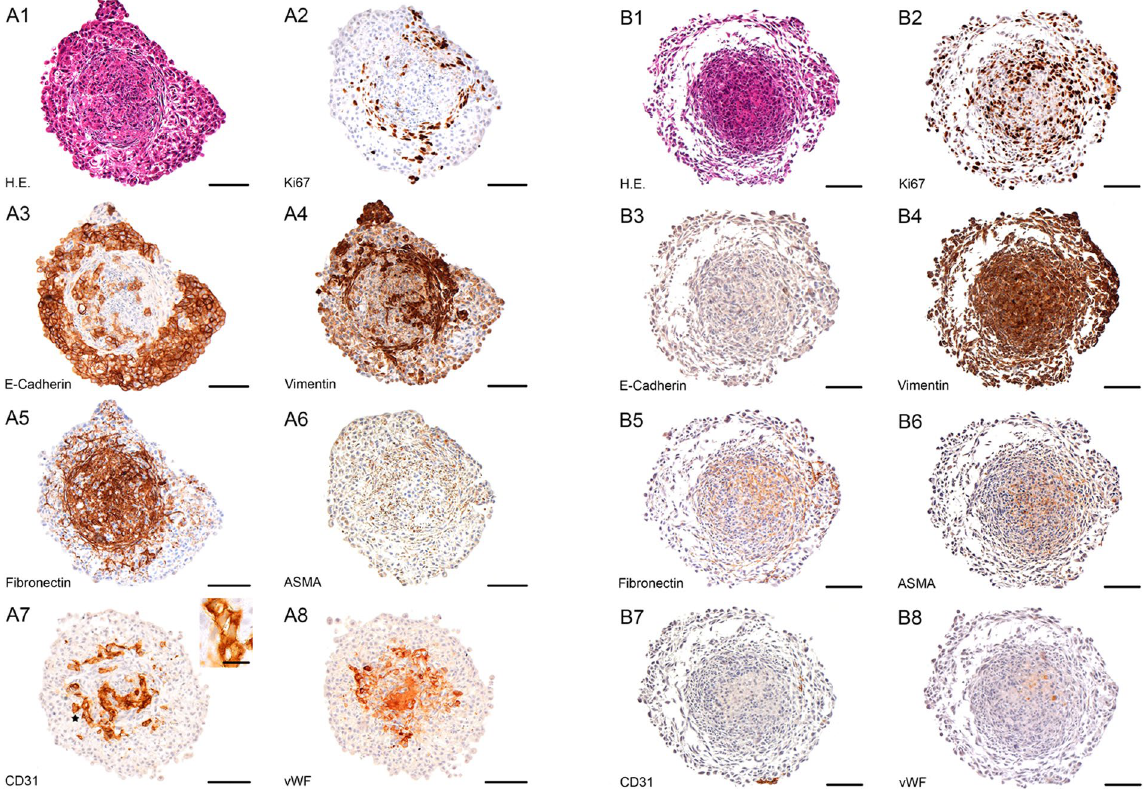
Figure 2. ( A ) A549 tri-cultures microtissue protein expression pattern (A1–A8): IHC slices of A549 with SV80 and HUVECs after 10 days. Endothelial cells are located in the fibroblast core of microtissues (A7). All cells started to express alpha-smooth muscle actin (A7) and vimentin (A4). Bar: 100 µ m. Inlet showing formation of endothelial cells as coherent structure. Bar: 20 µ m. ( B ) Colo699 tri-cultures microtissue protein expression pattern (B1–B8): IHC slices of Colo699 with SV80 and HUVEC after 10 days. Endothelial cells aggregated in small isles at the surface of microtissues (B7). All cells expressed ASMA (B6), vimentin (B4) and no E-cadherin (B3). Bar: 100 µ